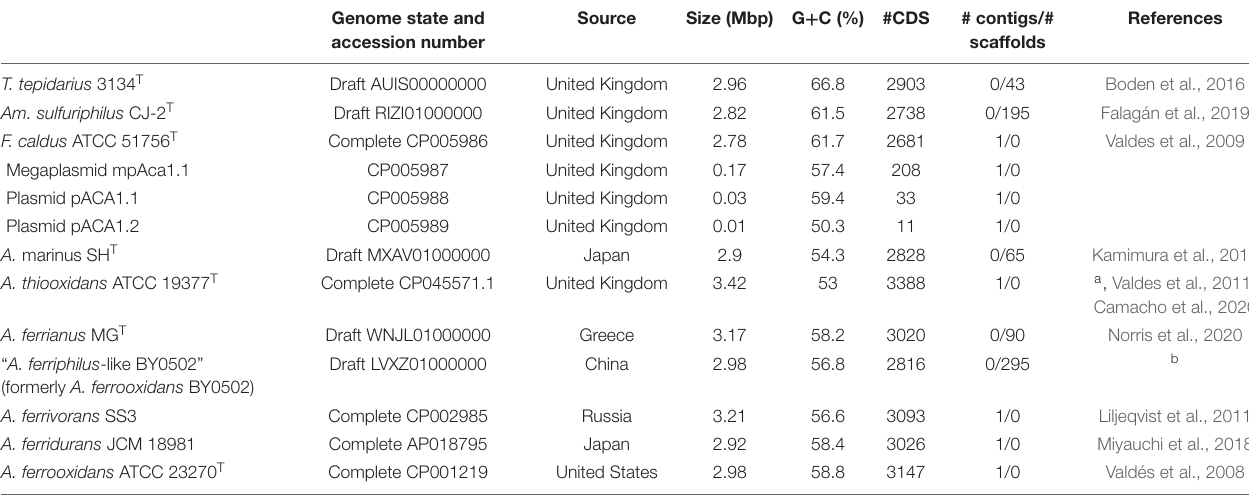
TABLE 1 | Strains, genome accession, and features of the selected representatives of the Acidithiobacillia